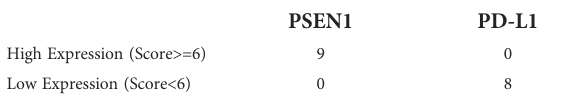
TABLE 1 Immunohistochemical Scores of PSEN1 and PD-L1 (CD274) in